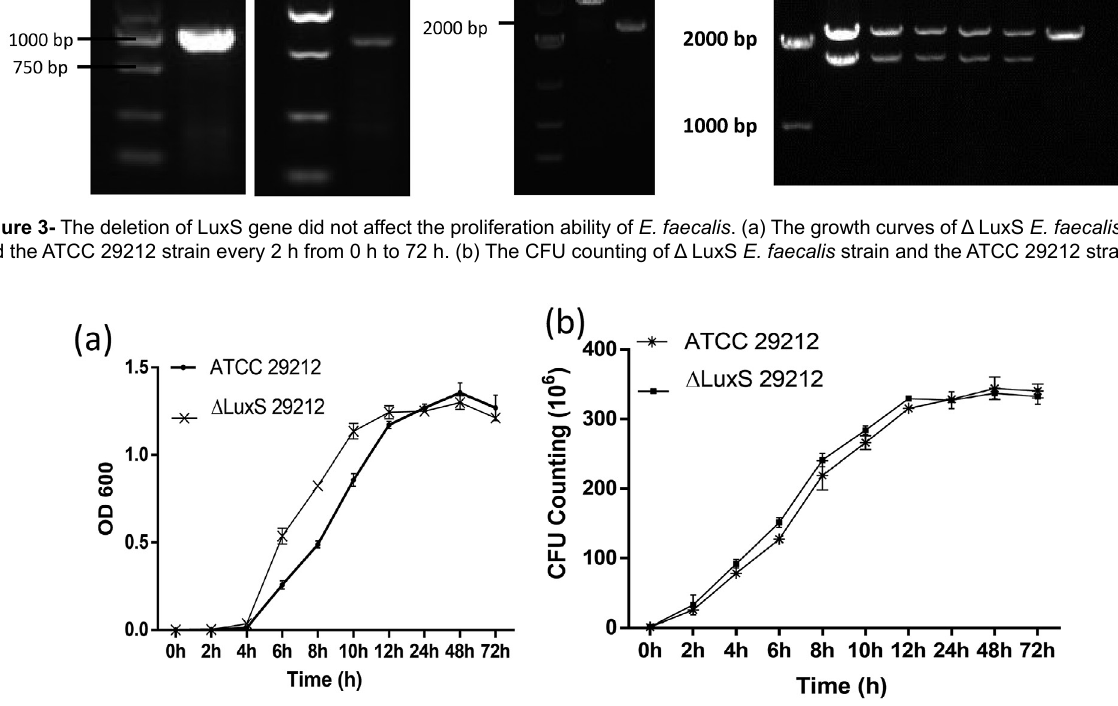
Amplification of the upper and down-stream homologous arm of the E. faecalis LuxS gene. M: Marker DL2000 1: LuxS upstream homologous arm fragment (P1 to P2), length is 961 bp; 2: LuxS down-stream homologous arm fragment (P3 to P4), length is 820 bp; (b) The identification of recombinant plasmid. M: Marker 1: Recombinant plasmid 2: pEASY-T1 vector; (c) The identification of the LuxS gene knockout in E. faecalis . M: DNA markerDGL 4000; Lane 1-5, upper band: recombination vector LuxS up and down homologous arm fragment interpose with the amp and kana genes; lower band: LuxS gene from up to low homologous arm (P1 to P4) Figure 4- Building the E. faecalis LuxS deficient strain D LuxS 29212 by